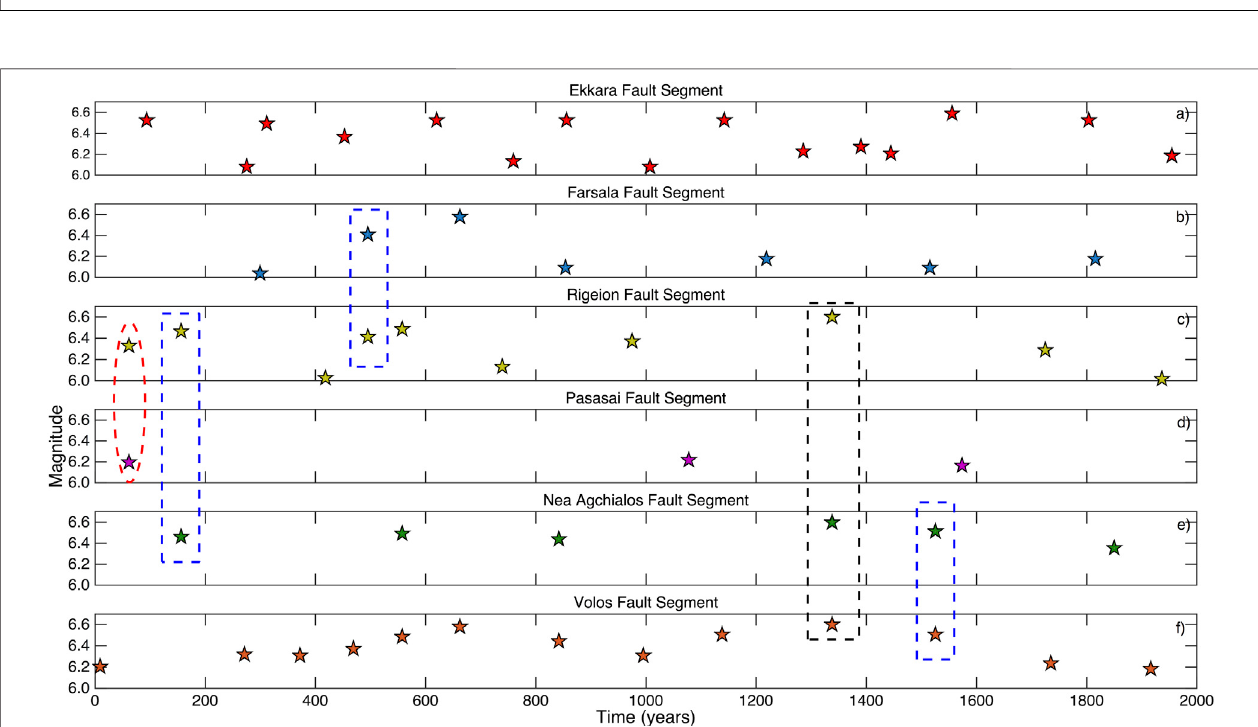
FIGURE7| Snapshot ofthe first2 kyrtemporal distribution ofthe M w ≥ 6.0 earthquakes ofthe best performed simulated catalog. Blue boxes indicate some ofthe combinationsofthetwosegmentruptures,whiletheblackoneindicatesoneofthethreecasesofthreesegmentruptures.Theredellipsedepictsacaseoftwoindividual fault segments ruptures (Mw (cid:1) 6.3 for Rigeion fault segment and Mw (cid:1) 6.2 for Pagasai fault segment) almost at the same time.